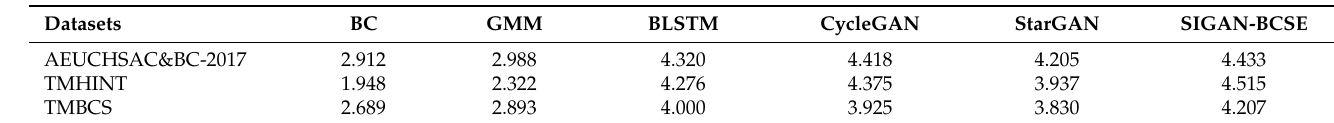
Table 6. P.563 evaluation of the enhanced BC speech obtained by different methods (single-ended indicator).